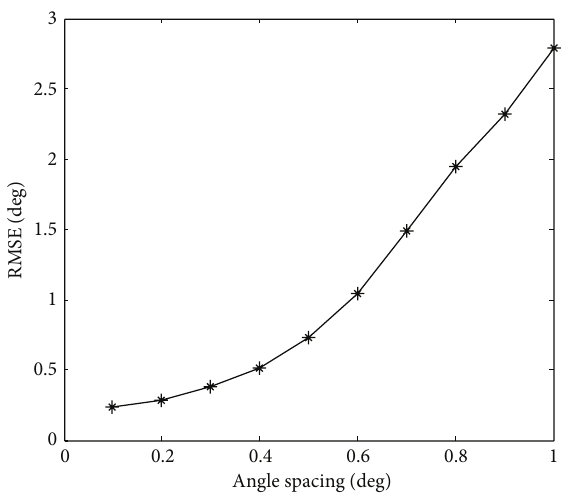
Figure 10: DOA tracking performance with different angle